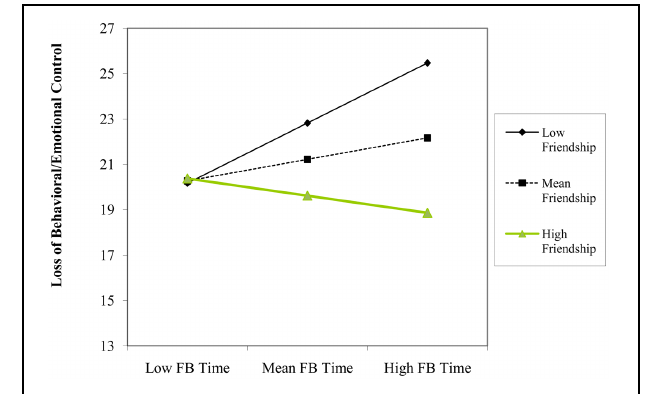
FIGURE 1 | Participant’s Facebook time and connection level as interactive predictors of overall scores on the Mental Health Index (MHI).